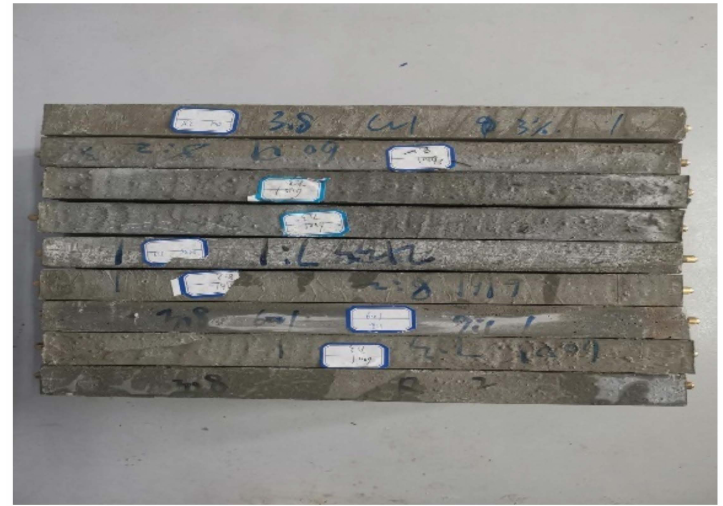
Figure 2. Dry shrinkage test sample.